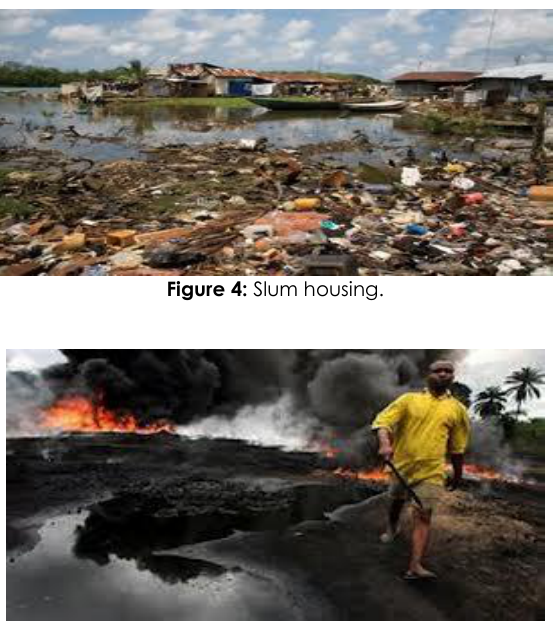
Figure 5: Bunkering-illegal tapings into pipelines.